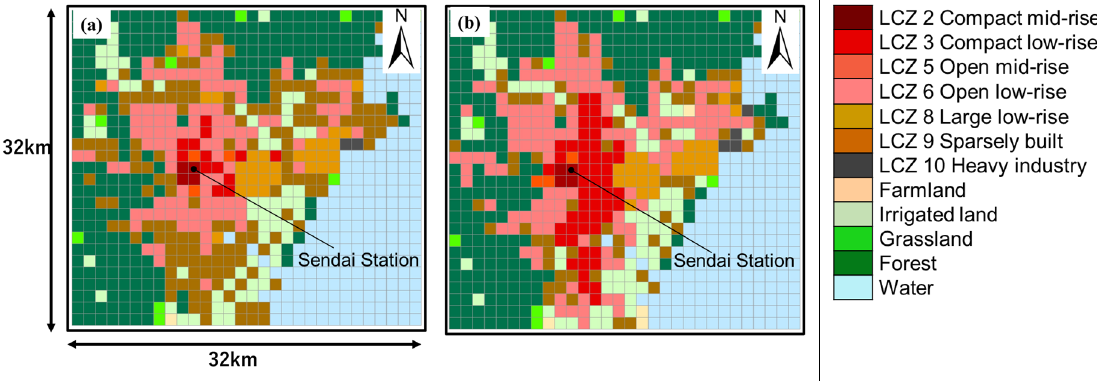
Figure 3. Land use data in Sendai. ( a ) LCZ map in 2002; ( b ) LCZ map in 2022.